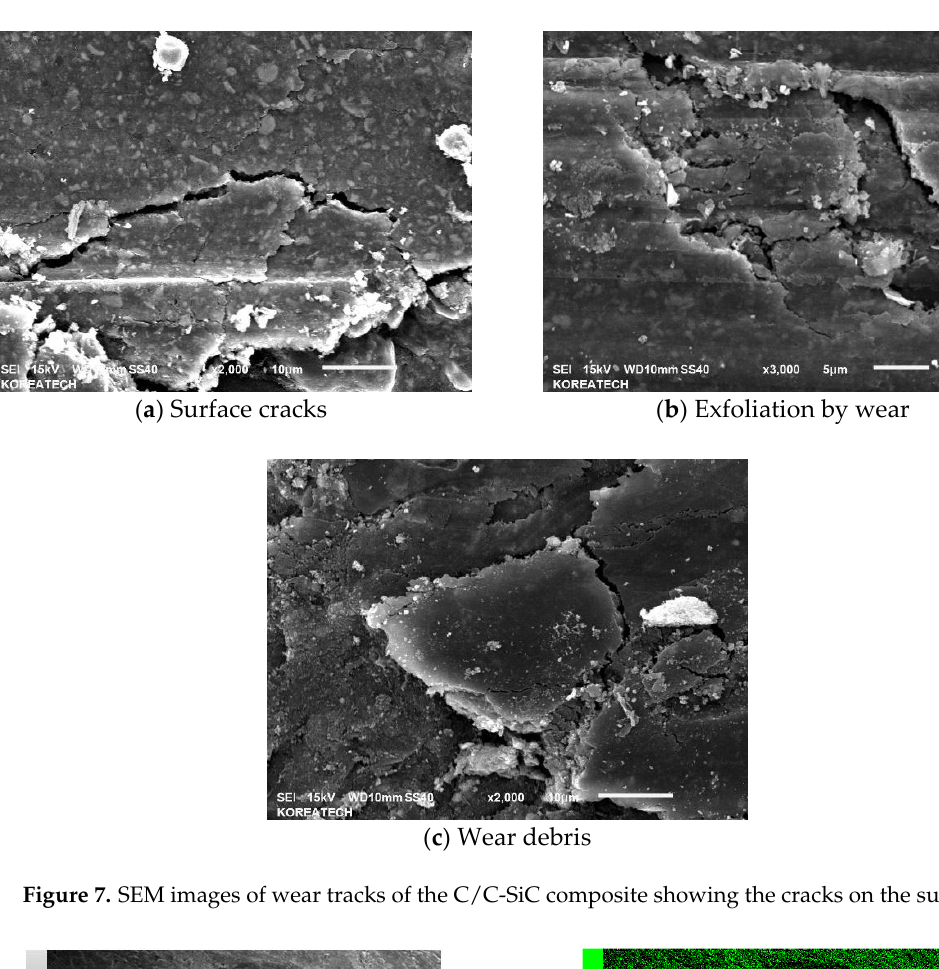
Figure 6. SEM images of wear track formed on the C/C-SiC composite at temperatures of 25 °C ( a ); 100 °C ( b ) and 200 °C ( c ).